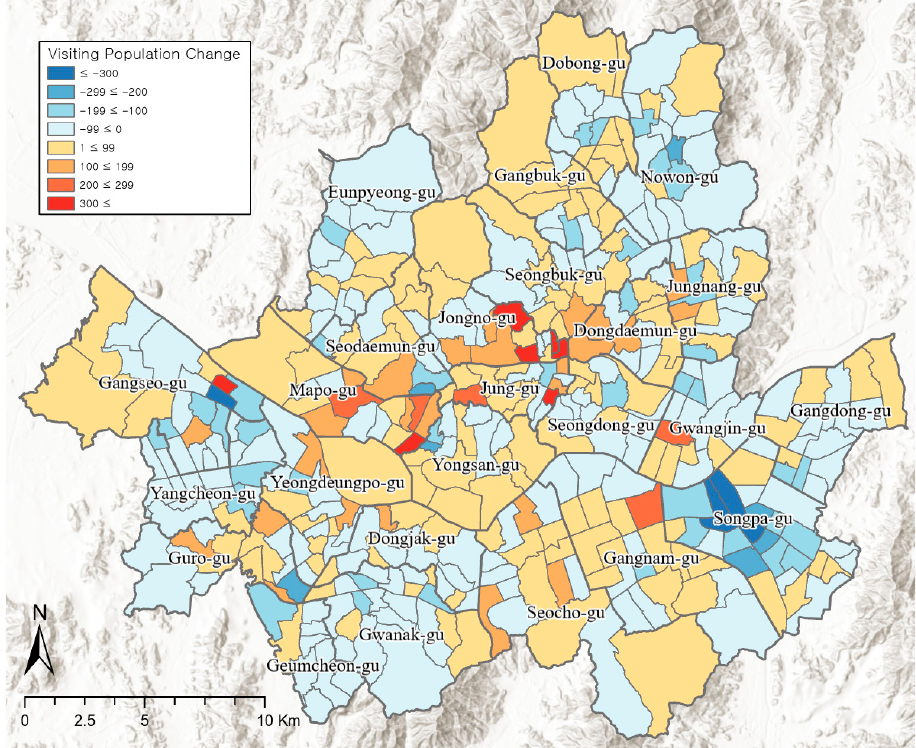
Figure 1. Spatial distribution of visiting population differences between weekdays with high PM concentrations and control days.